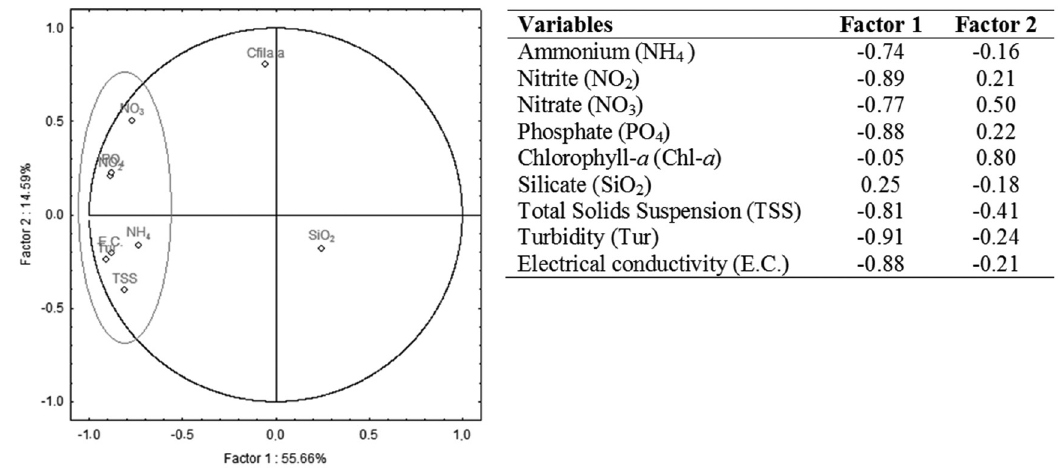
Figure 6. Ordination of the data from PCA analysis based on limnological variables, inorganic dissolved nutrients, chlorophyll -a and TSS (total suspended sediment).